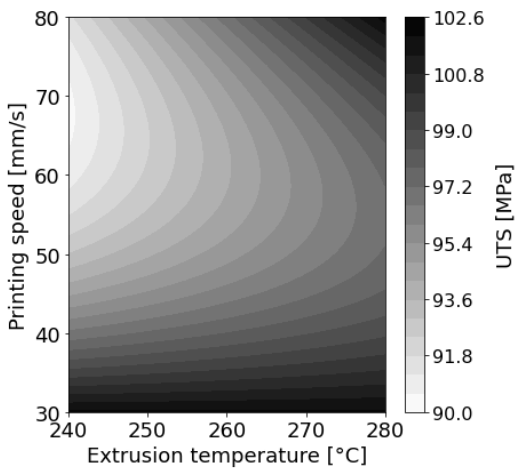
Figure A7. Contour plot for T ext and v according to the ML-based prediction model.